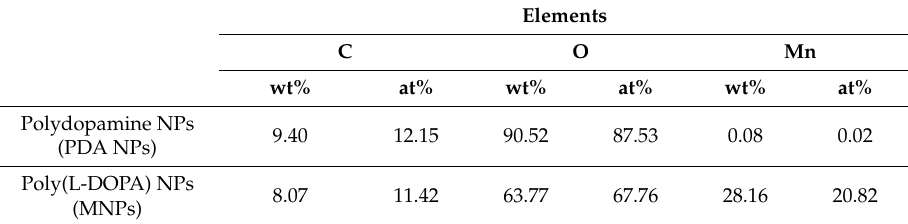
Table 1. Elemental analysis of polydopamine nanoparticles (NPs) and poly(L-DOPA) NPs.